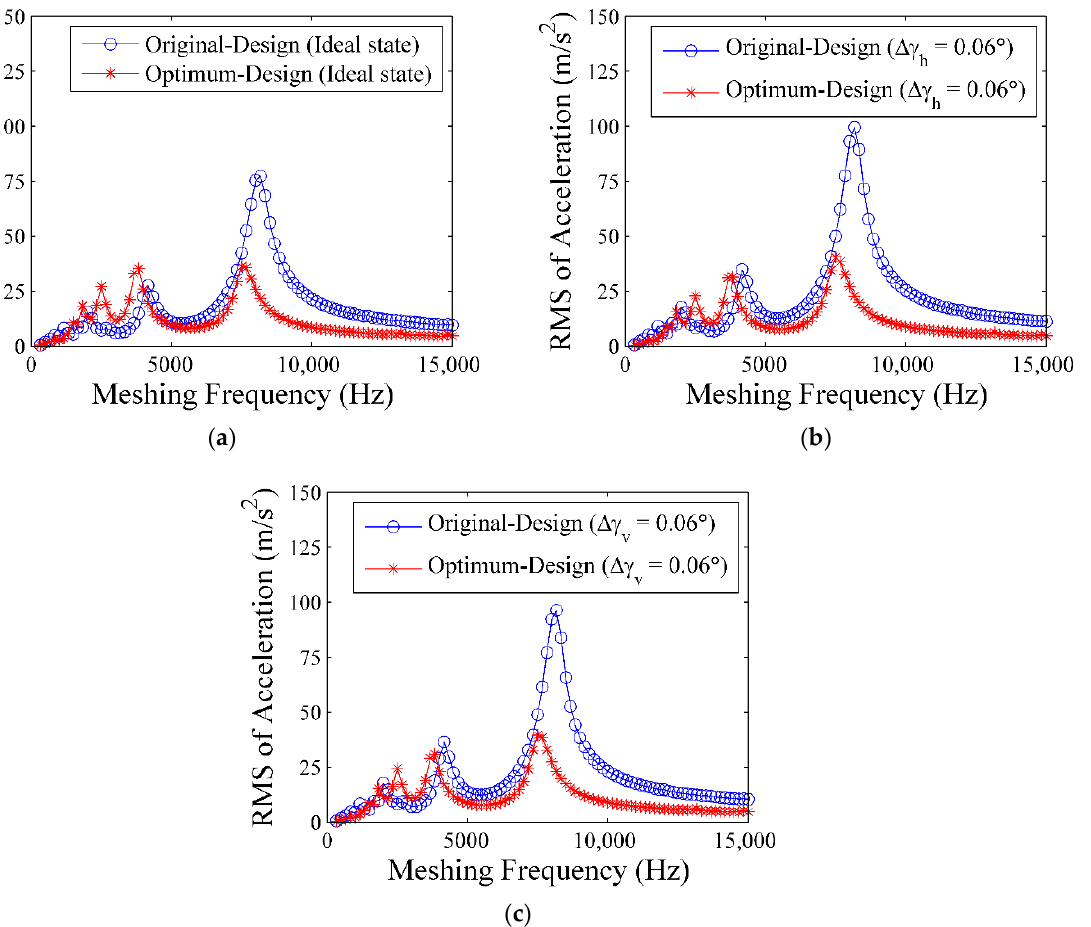
Figure 12. RMS of acceleration signal: ( a ) ideal state; ( b ) horizontal axial misalignment; ( c ) vertical axial misalignment. Table 6. RMS of acceleration at natural frequency. (Unit: m/s 2 ).